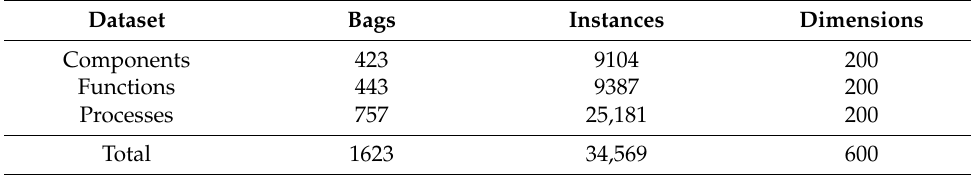
Table 9. Biocreative dataset. Total number of bags and instances for each